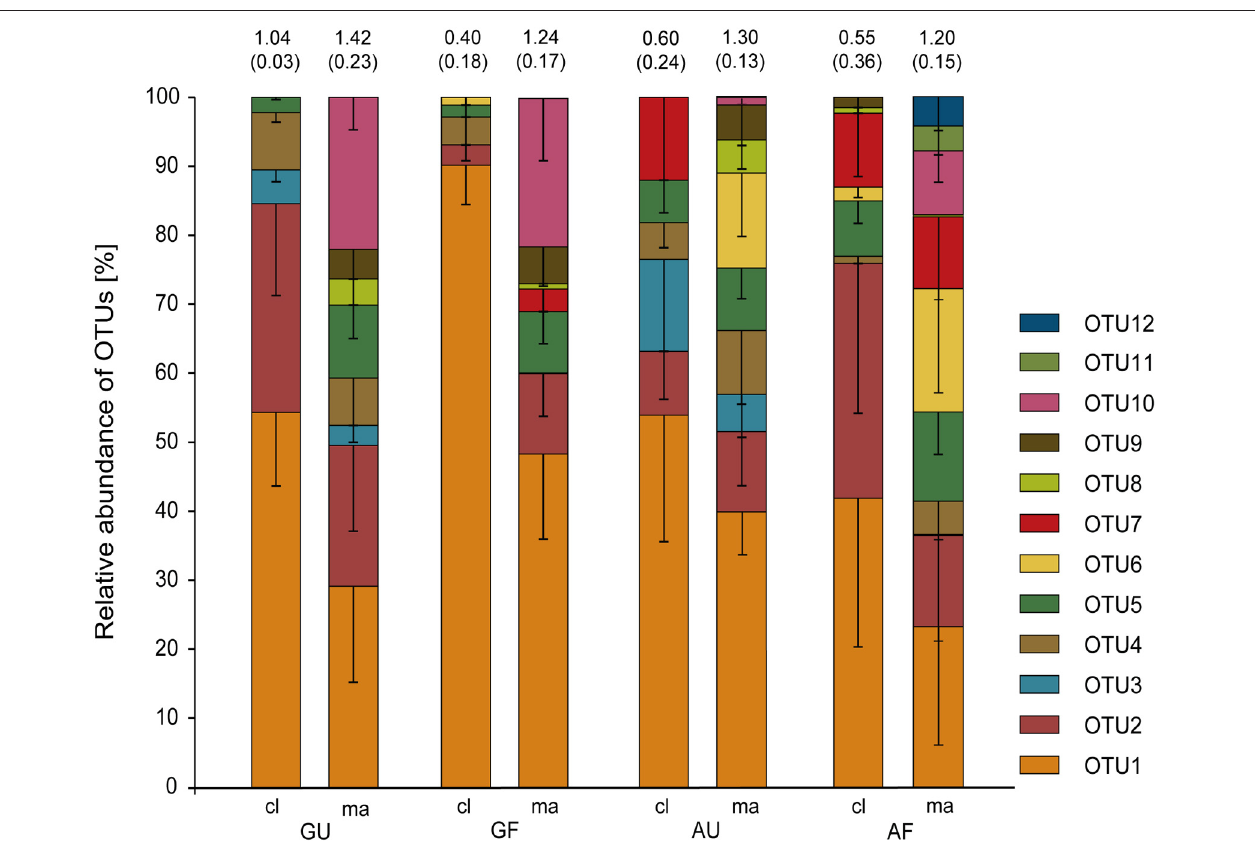
FIGURE 3 | Relative abundance of AOA amoA OTUs defined at 15% nucleotide sequence dissimilarity as detected by clone library analysis and microarrays. Error bars denote standard errors ( n = 3 or 4). Numbers above the bars are Shannon’s index of diversity ± standard